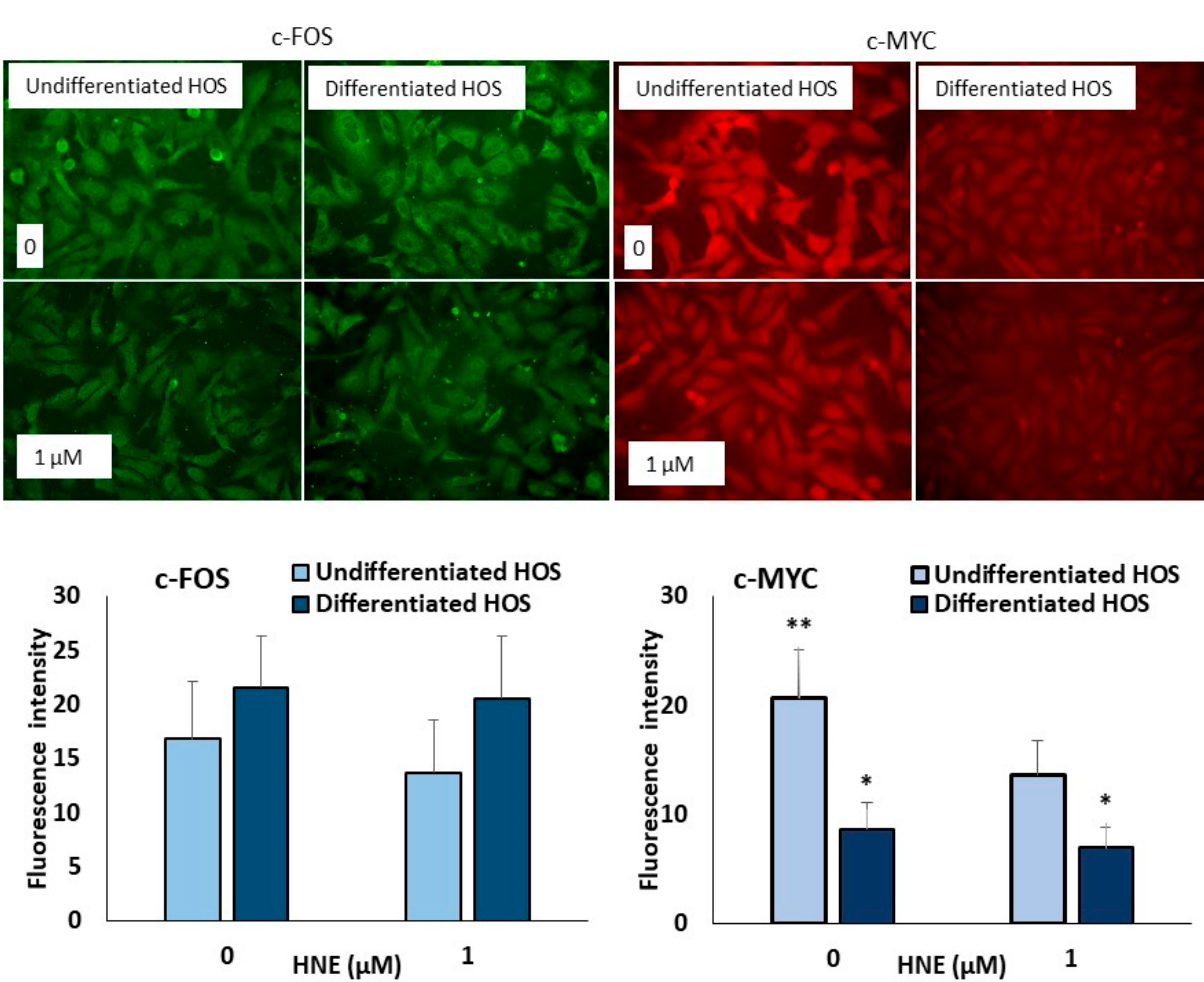
Figure 6. Representative immunofluorescence labeling for c-FOS and c-MYC in differentiated and undifferentiated HOS. Difference according to t -test significant between two cultures, * p < 0.05; and 0 and 1 µM HNE, ** p < 0.05.